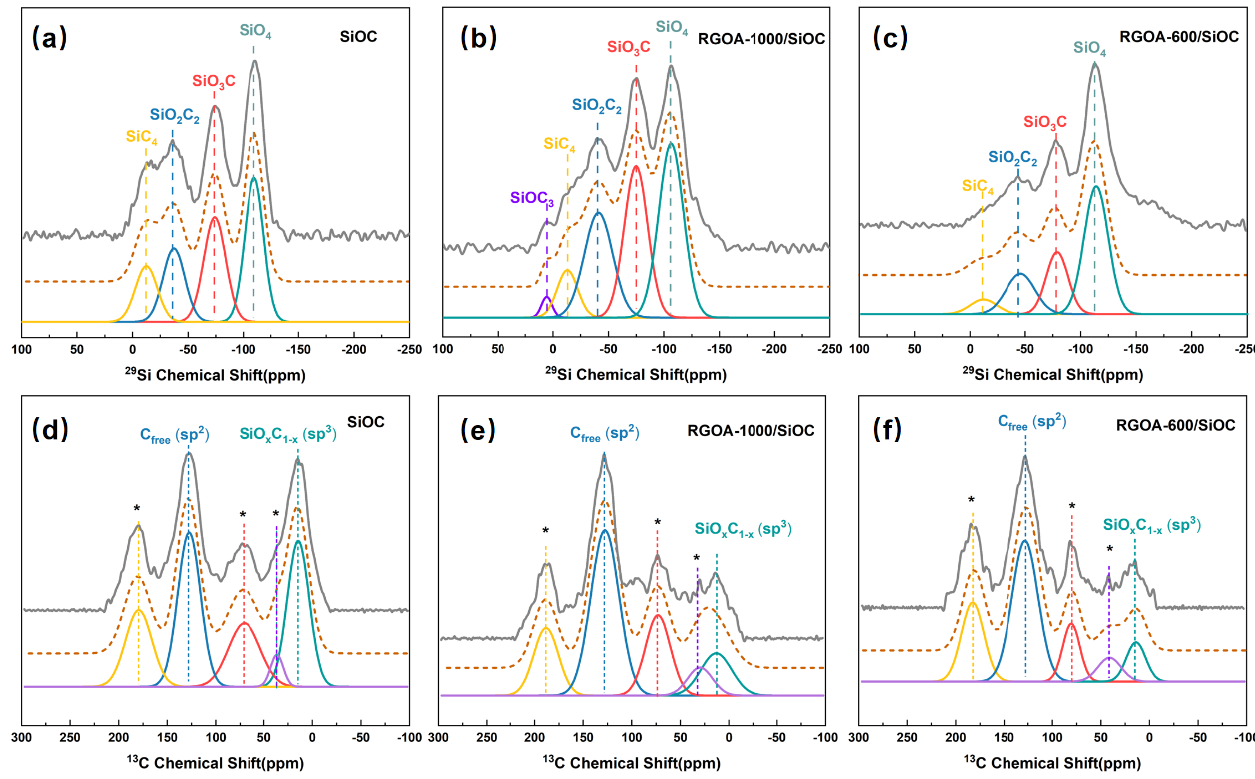
Figure 6. The 29 Si and 13 C MAS NMR spectra of ( a , d ) SiOC, ( b , e ) RGOA-1000/SiOC, and ( c , f ) RGOA-600/SiOC. The experimental spectra are shown by the solid grey line on top, followed by the simulated spectra (dashed brown lines), and the individual simulation components (solid colored lines). Table 3. Si-containing structural units in SiOC and RGOA-modified SiOC nanocomposites according to the simulation of 29Si MAS NMR spectra.